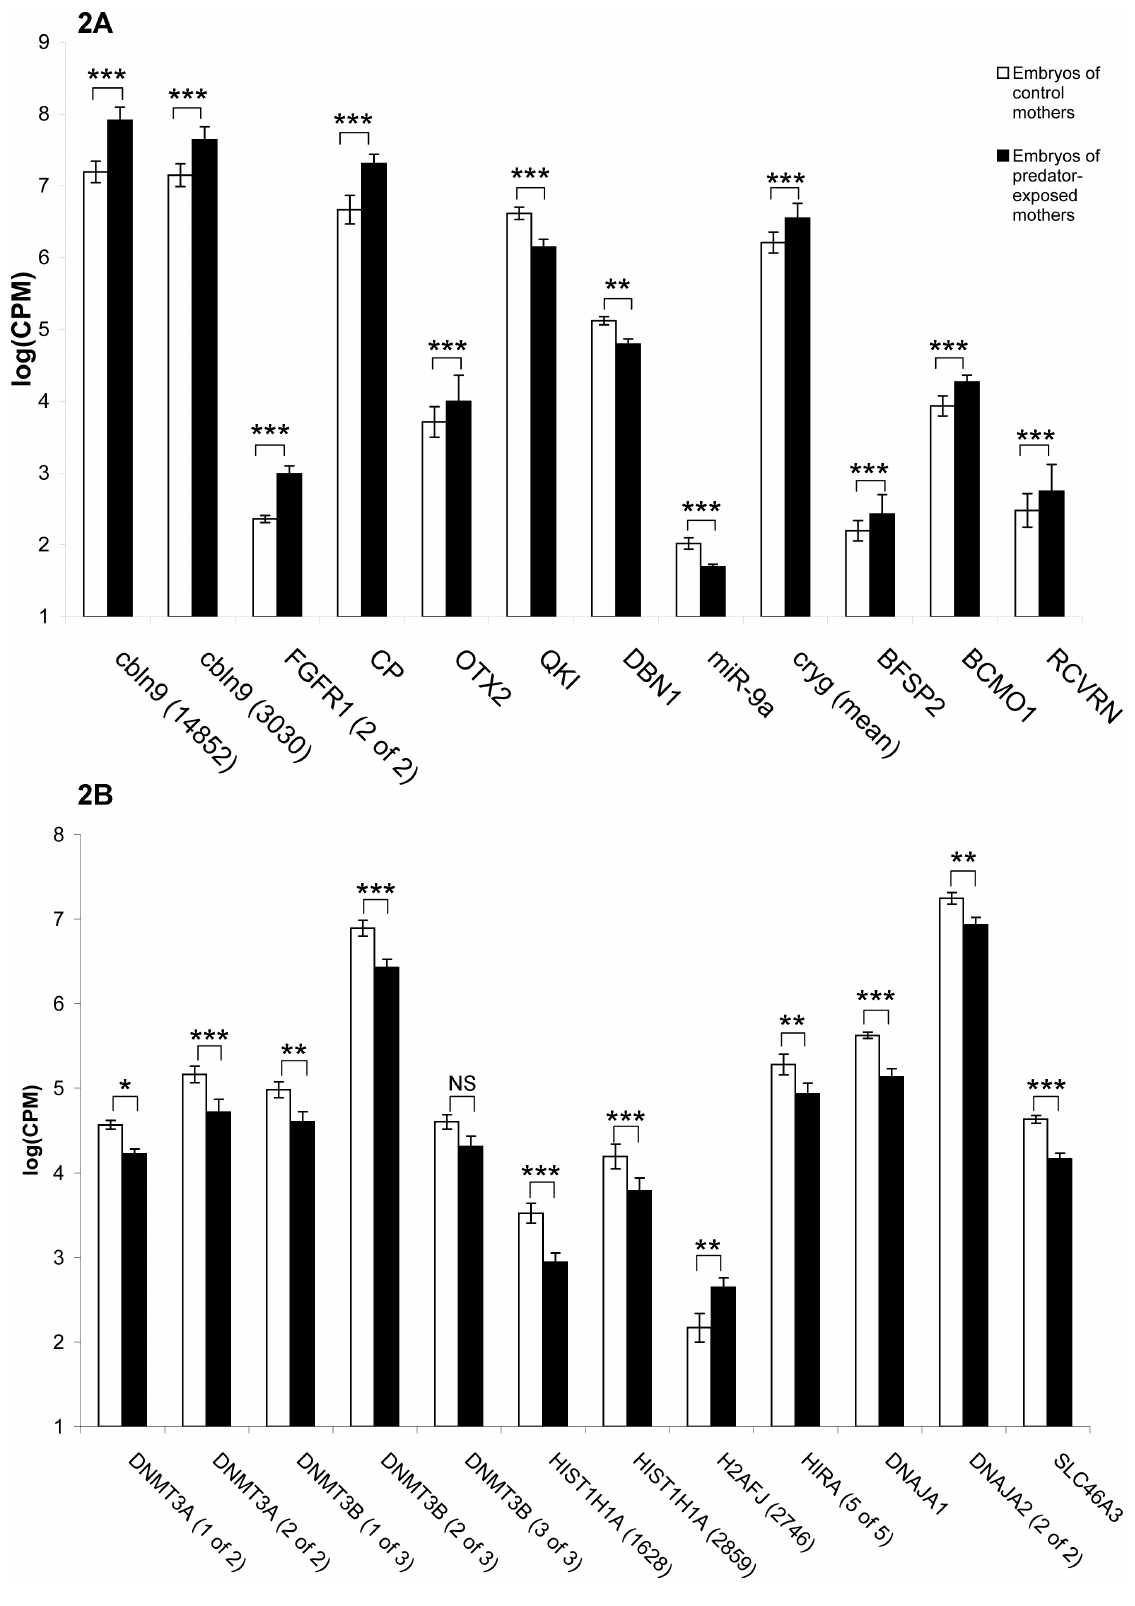
Figure 2. Maternal exposure to predation risk altered expression of embryonic genes involved in neural growth and epigenetic modification. A) The expression of DNA methyltransferase genes, histone genes, and genes that interact with histone and DNA methylation in 3dpf stickleback embryos from mothers exposed to a predator and control mothers. B) The expression of genes involved in the proliferation and